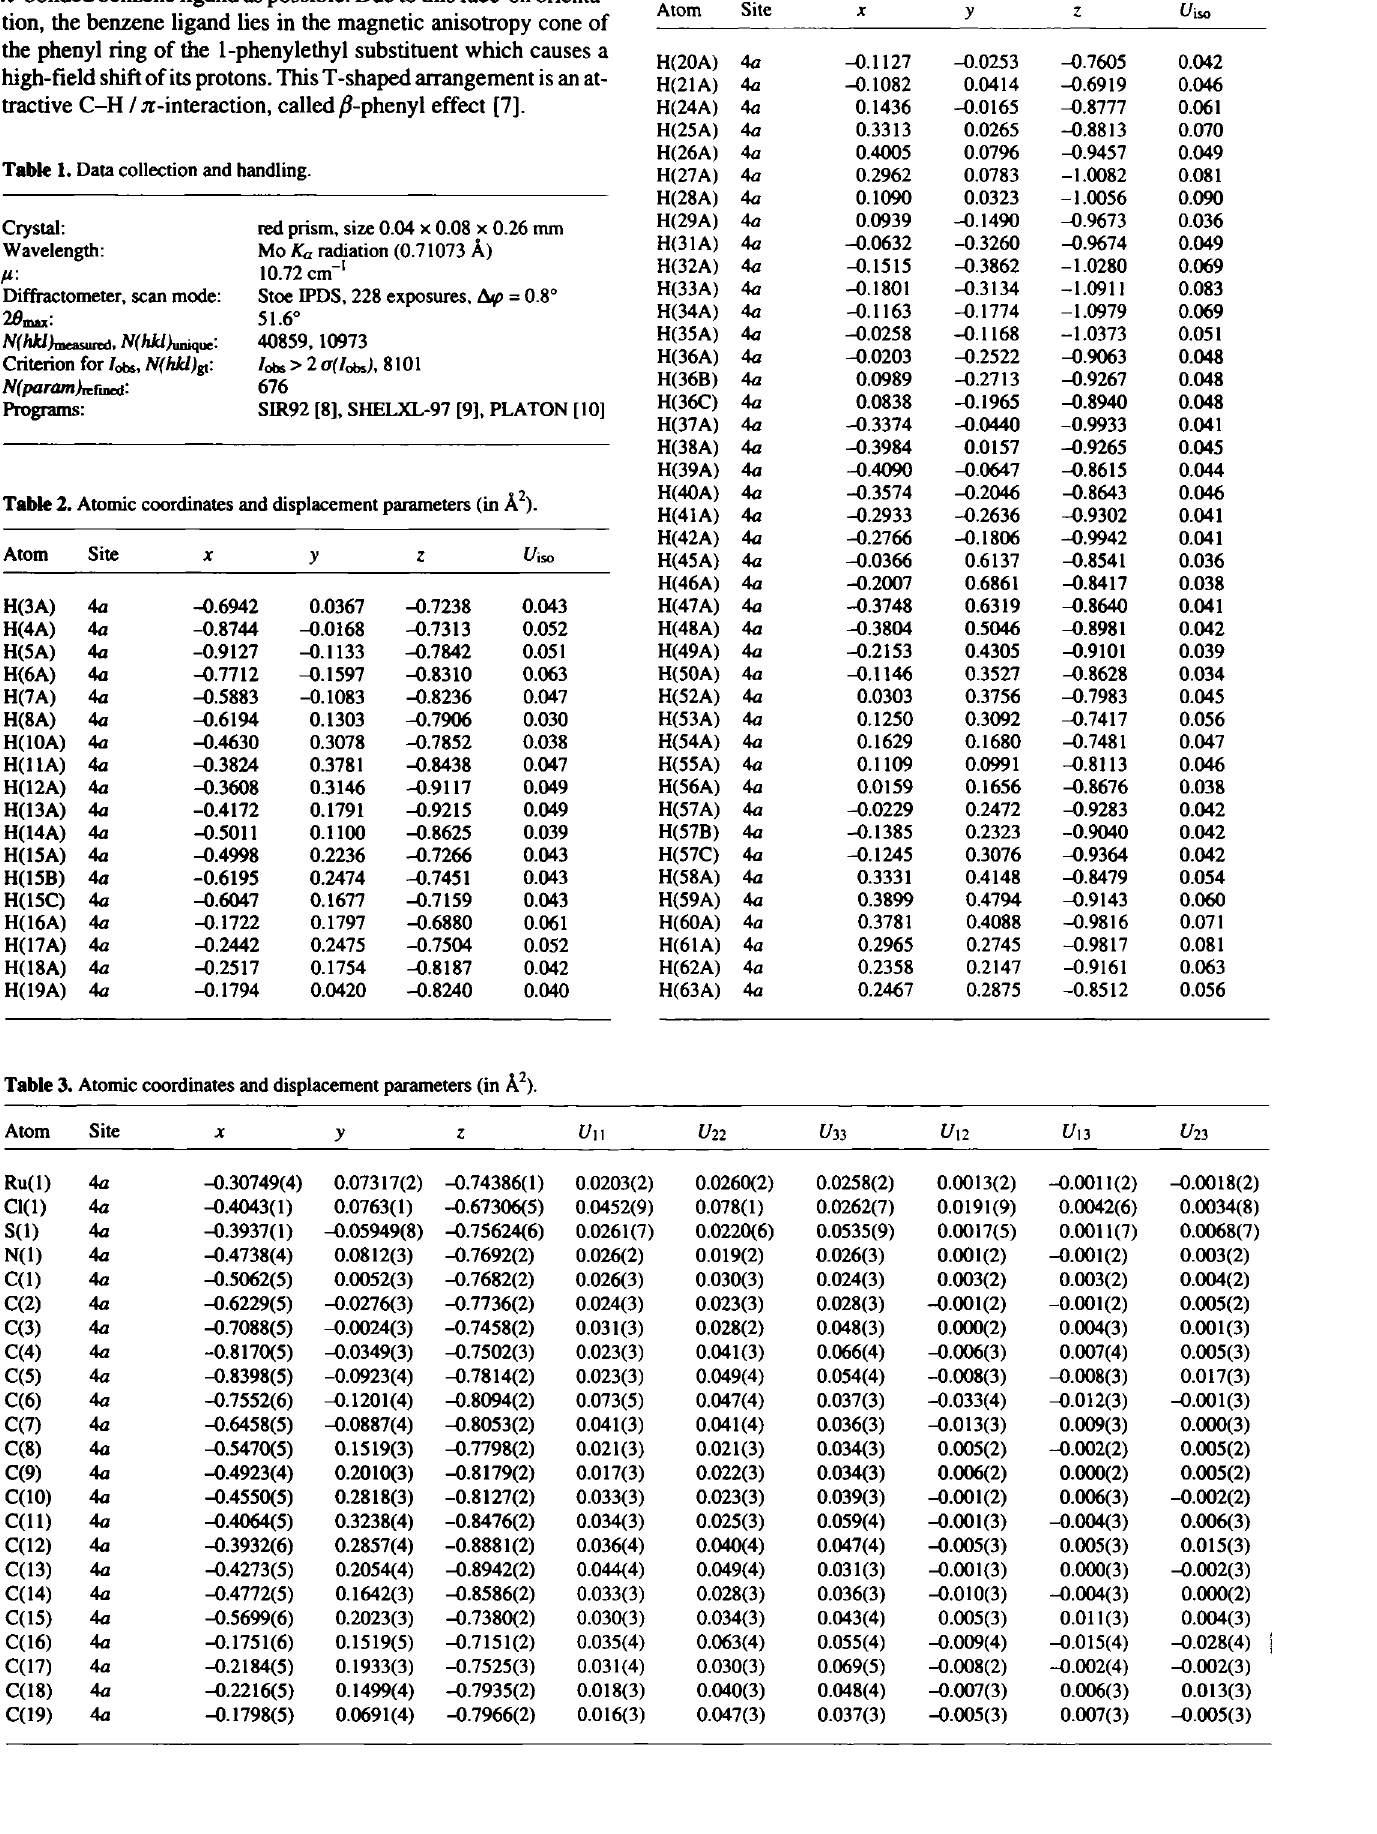
Table 2. Atomic coordinates and displacement parameters (in Â 2 ).